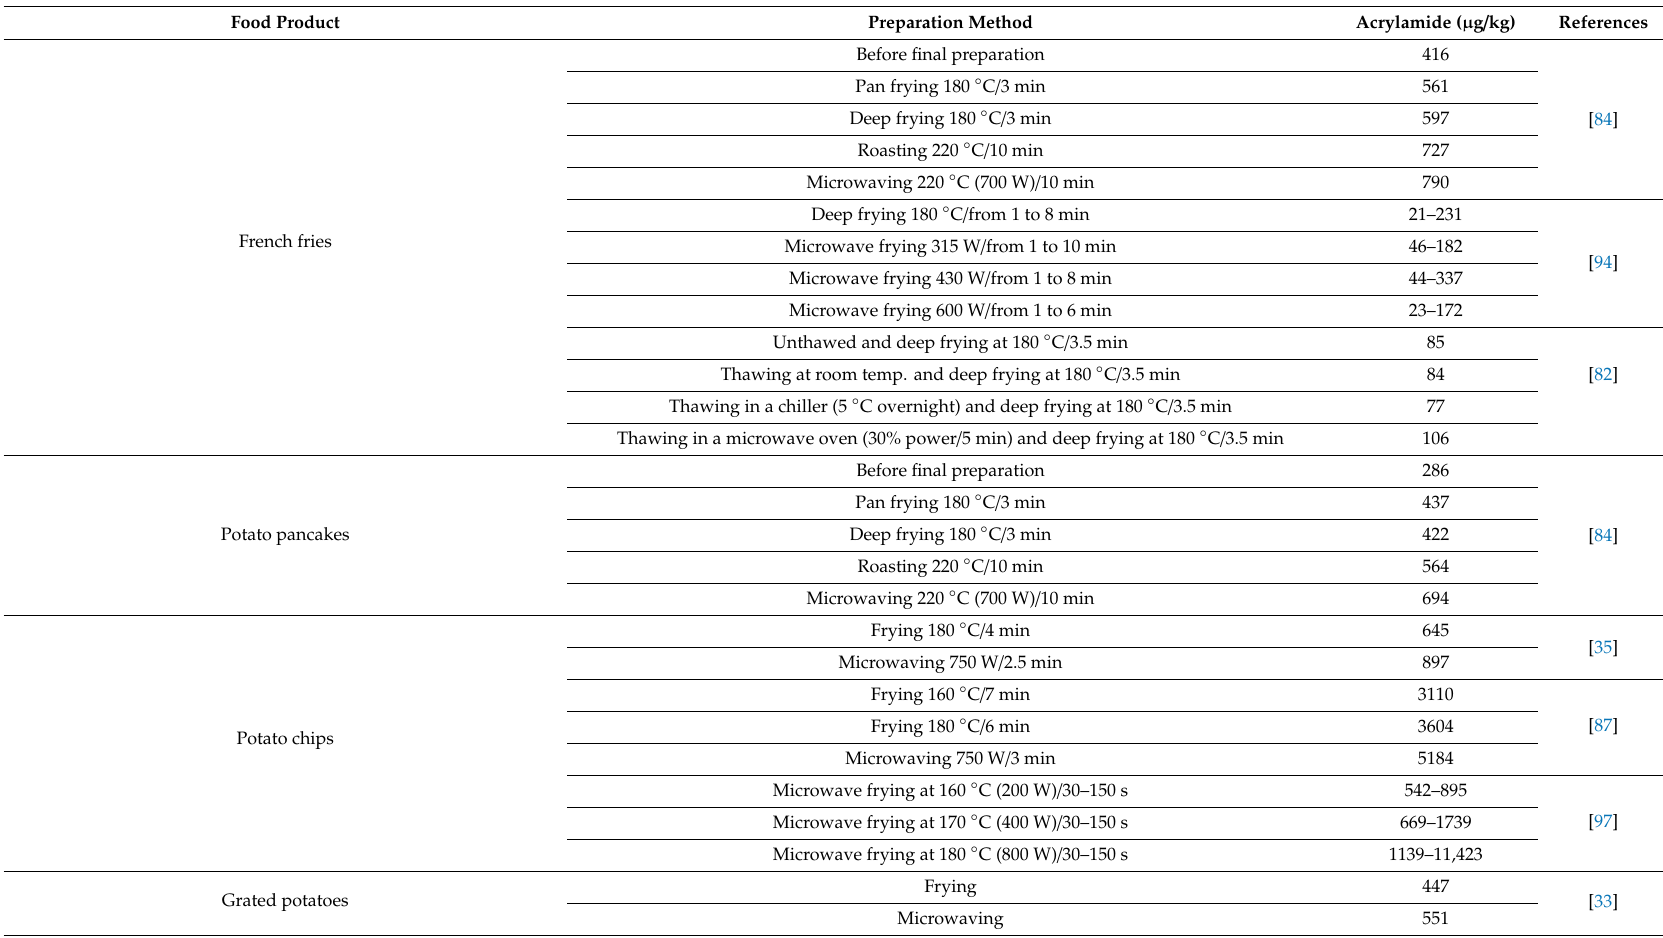
Table 2. E ff ect of conventional and microwave processing techniques on acrylamide content in di ff erent food products ( µ g /